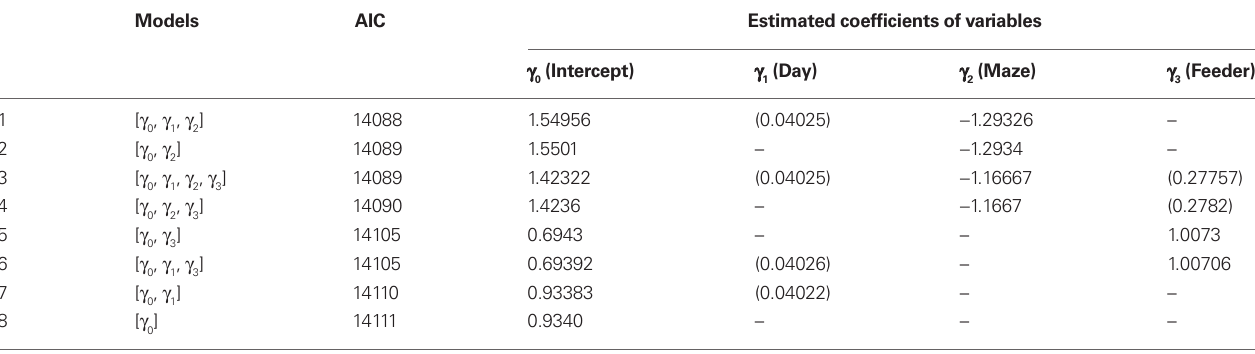
Table A4 | The day – maze model yielded the smallest AiC, but the effect of day was not reliable for its coefficient. Models